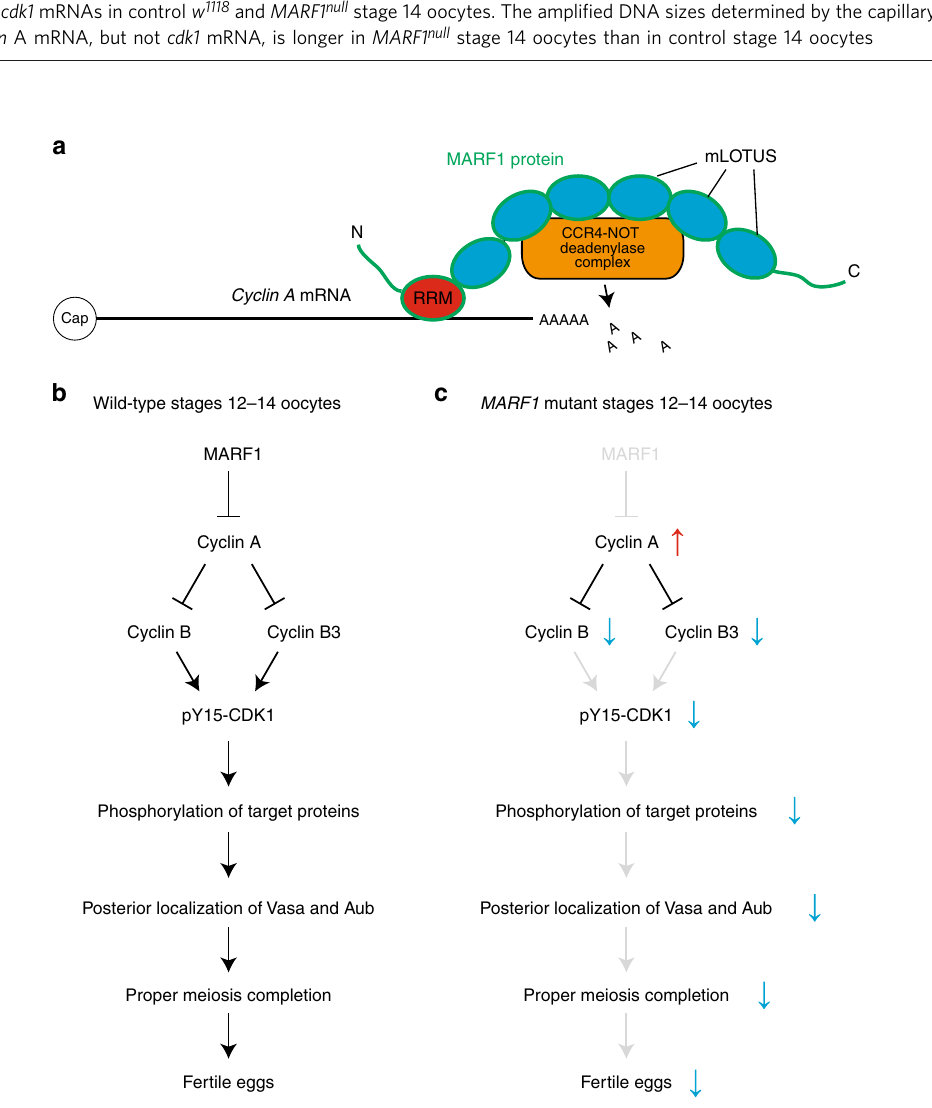
Fig. 10 Models for MARF1 function in oocytes. a RRM of MARF1 binds cyclin A mRNA and the mLOTUS domains of MARF1 binds and recruits the CCR4- NOT deadenylase complex(es) to cyclin A mRNA to shorten its poly-A tail. b MARF1 reduces Cyclin A protein level in stages 12 – 14 oocytes. This leads to the protein expression of Cyclin B and Cyclin B3, which results in phosphorylation of CDK1 Tyr15. Tyr15-phosphorylated CDK1 phosphorylates many target proteins, which may promote posterior germplasm localization of Vasa and Aubergine. The proper protein phosphorylation and/or proper Vasa/Aub localization to germplasm are required for successful completion of meiosis and fertility of eggs. c Loss of function of MARF1 causes an increase in Cyclin A protein level, which results in decrease of Cyclin B and Cyclin B3 protein levels in late-stage oocytes. This leads to a reduced phosphorylation of CDK1 Tyr15 and therefore an altered phosphorylation pattern of CDK1 target proteins. This may cause loss of the posterior germplasm localization of Vasa and Aubergine. Meiosis cannot complete successfully and therefore eggs are